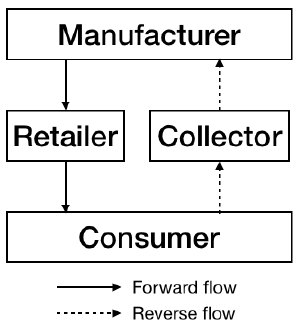
Figure 1. Configuration of the closed-loop supply chain considered in this study.